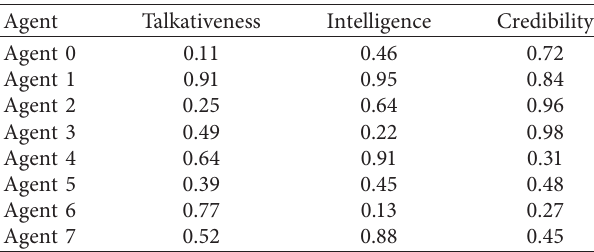
Table 2: Agents’ attributes in a representative 8-agent